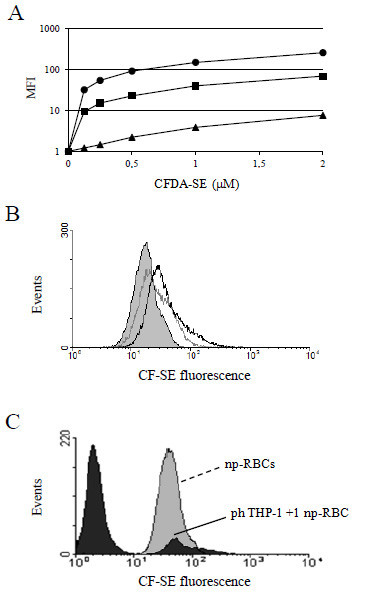
Fluorescent labelling of np- and p-RBCs with CF-SE. (A) Dependence of MFI on CFDA-SE concentration (μM final) and haematocrit in np-RBC. (black circle) 0.05%, (black square) 0.5%, (black triangle) 5% haematocrit, corresponding to 5 x 103, 5 x 104, 5 x 105 RBCs/μl, respectively. (B) CF-SE fluorescence of np-RBCs (full grey histogram), ring-parasitized RBCs (light grey line), and troph-parasitized RBCs (dark grey line). np- and p-RBCs were incubated as indicated in (A). (C) Absence of fluorescence quenching in np-RBCs after phagocytosis. Fluorescence of CF-SE-labelled uningested np-RBCs (full grey histogram, MFI: 48.3 ± 1.6, N = 3) and of phTHP-1 cells fed with limiting numbers of CF-SE-labelled np-RBCs (RBCs/THP-1 ratio = 1, full black histogram, MFI: 49.7 ± 1.1, N = 3) were very similar. For details, see Methods.